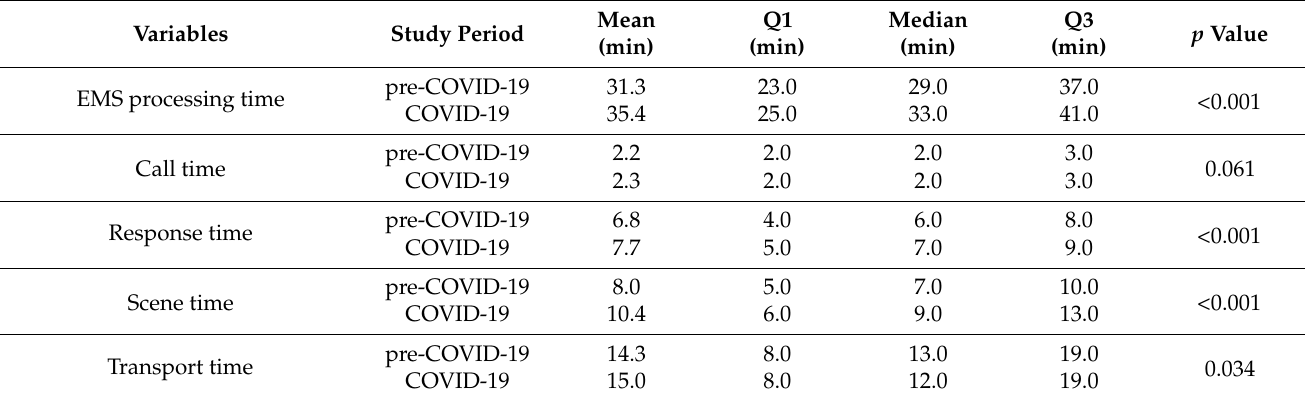
Table 1. Comparison of EMS processing time for patients with acute stroke symptoms before and during COVID-19.